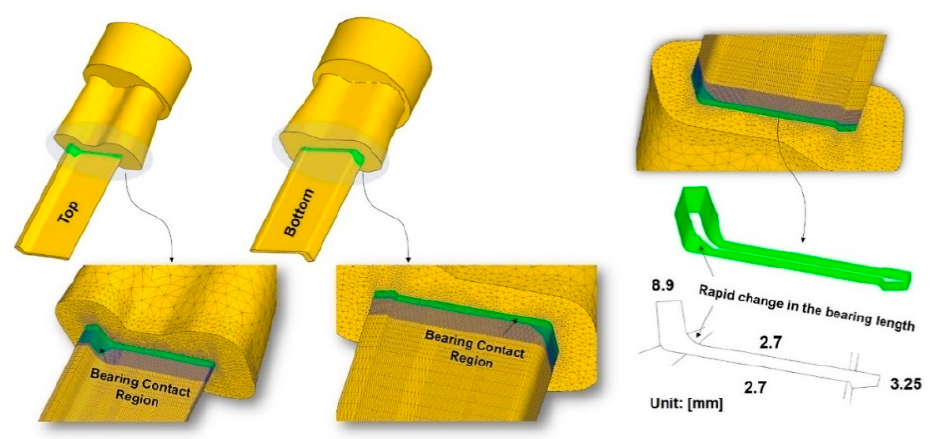
Figure 8. Bearing location and dimensions of the L-shaped sample extrusion.